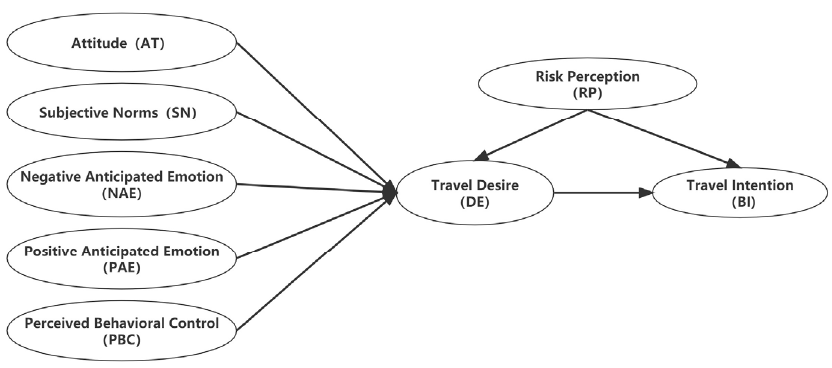
Figure 2. Research Figure 2. Research model.